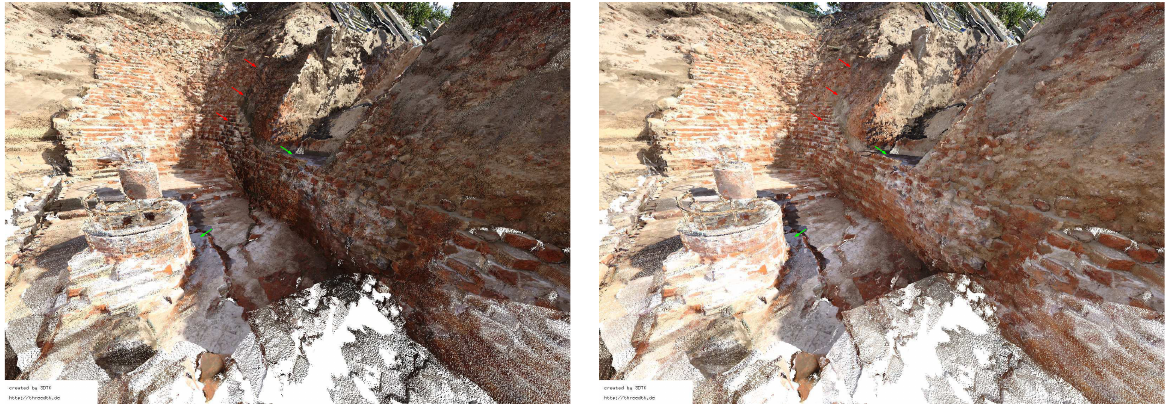
Figure 6. Stephanitorzwinger, Bremen, Germany. Details from the point cloud before (left) and after optimization (right) with equal point density. Note the scattered dark pattern on the brick wall, which disappeared after exposure correction.